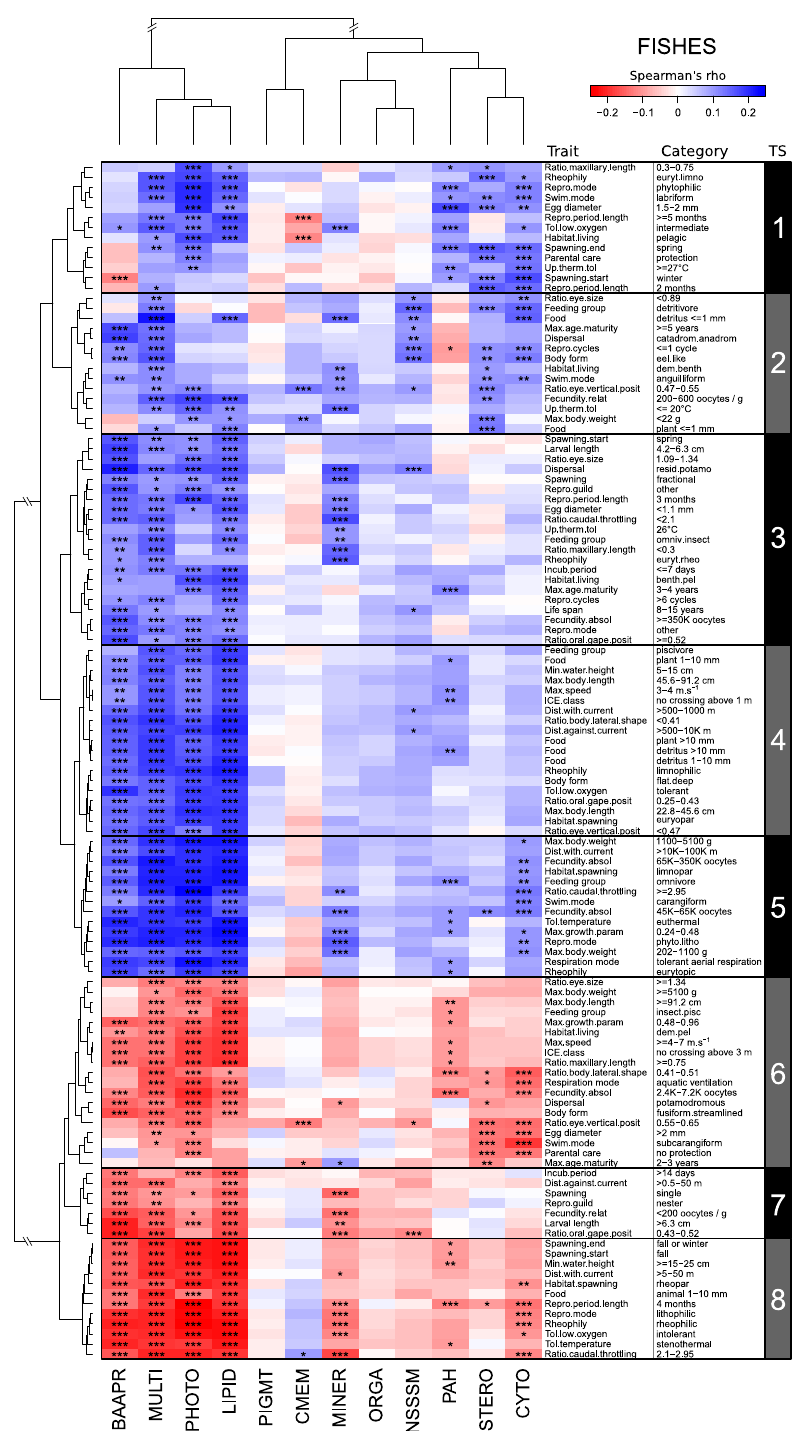
Figure 4. Heatmap of the non-parametric correlations between the utilization of trait categories by fish assemblages (provided by CWM m calculation) and the 12 studied MoAs, expressed in log(x + 1)-transformed sums of toxic units. The color of each cell indicates the value of the correlation coefficient (Spearman’s rho) for a given couple of “trait category × MoA”. Horizontal lines delimit trait syndromes, numbered (1 to 8) on the right side of the heatmap. The full labels of MoAs are in Table 1. Further details about the heatmap and the dendrograms are provided in Section 2. * p < 0.05, ** p < 0.01 and *** p < 0.001. TS = trait syndrome. N = 2007 sampling events.